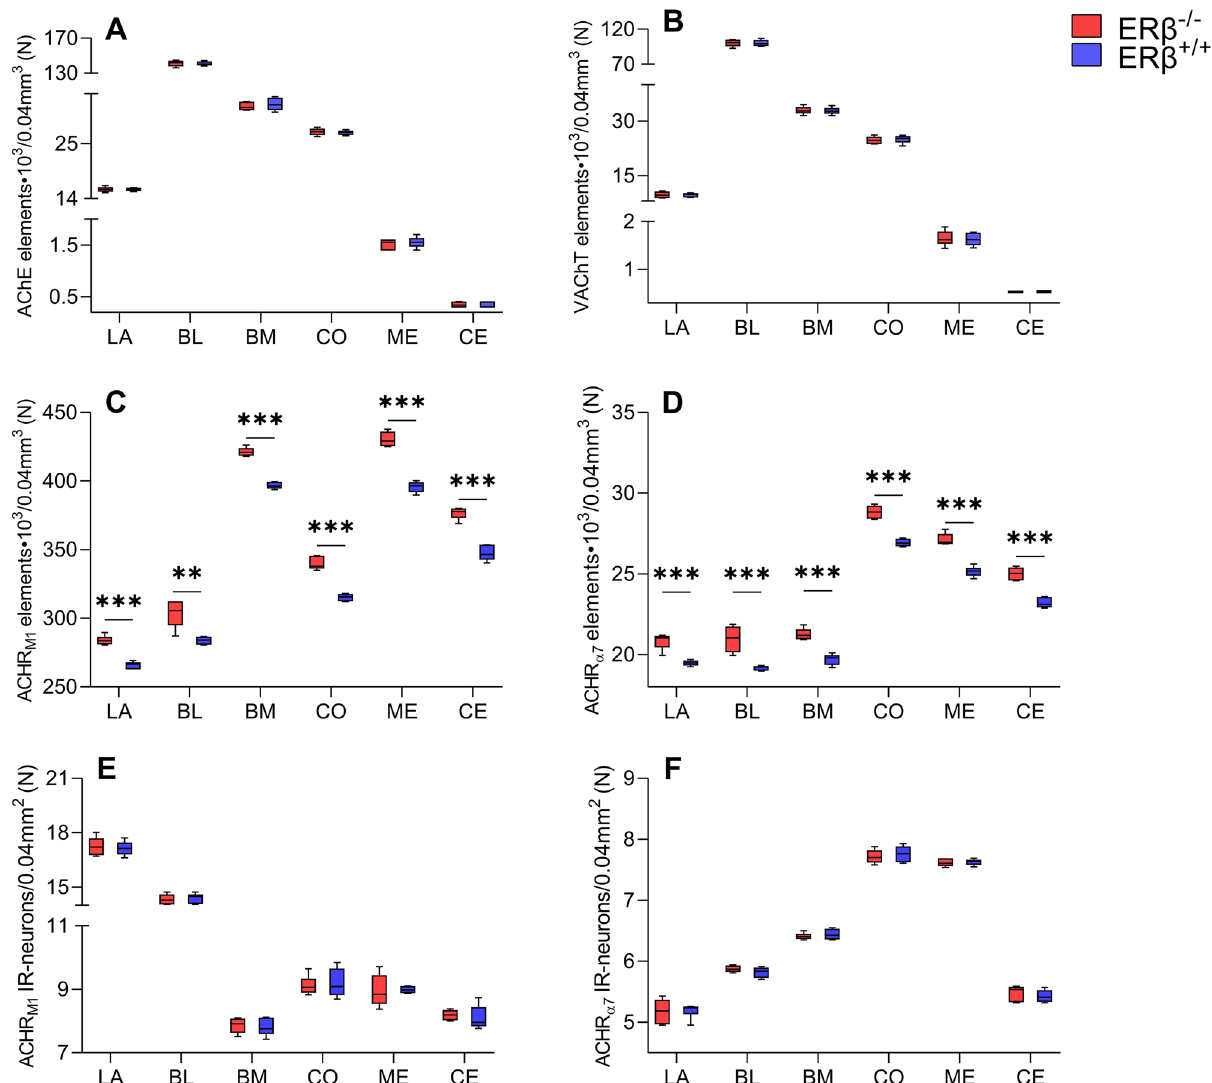
Figure 5. The densitometry of cholinergic markers such as acetylcholinesterase (AChE), vesicular acetylcholine transporter (VAChT), muscarinic acetylcholine type 1 receptor (AChR M1 ) and alpha-7 nicotinic acetylcholine receptor (AChR α7 ) in the amygdala of ERβ knock-out (ERβ −/− ) and wild-type (ERβ +/+ ) mice, n = 6 per group. Note that the volume density of AChE ( A ) and VAChT ( B ) do not differ in both mice lines, but for AChR M1 ( C ) and AChR α7 ( D ) is significantly elevated in ERβ −/− mice when compared to ERβ +/+ mice. Additionally, note that the automated cells counting for AChR M1 ( E ) and AChR α7 ( F ) are not affected due to ERβ deficiency. Data are expressed as a box-and-whiskers plots, with the "box" depicting the median and the 25th and 75th quartiles, and "whiskers" showing 5th and 95th percentile. ** ( p ≤ 0.01) and *** ( p ≤ 0.001) indicates statistically significant differences between the studied groups of mice (ERβ −/− and ERβ +/+ mice) analysed by Student’s t-test. Elements—immunoreactive somata, fibres and neuropil. LA—lateral nucleus, BL—basolateral nucleus, BM— basomedial nucleus, CO—cortical nucleus, ME—medial nucleus and CE—central